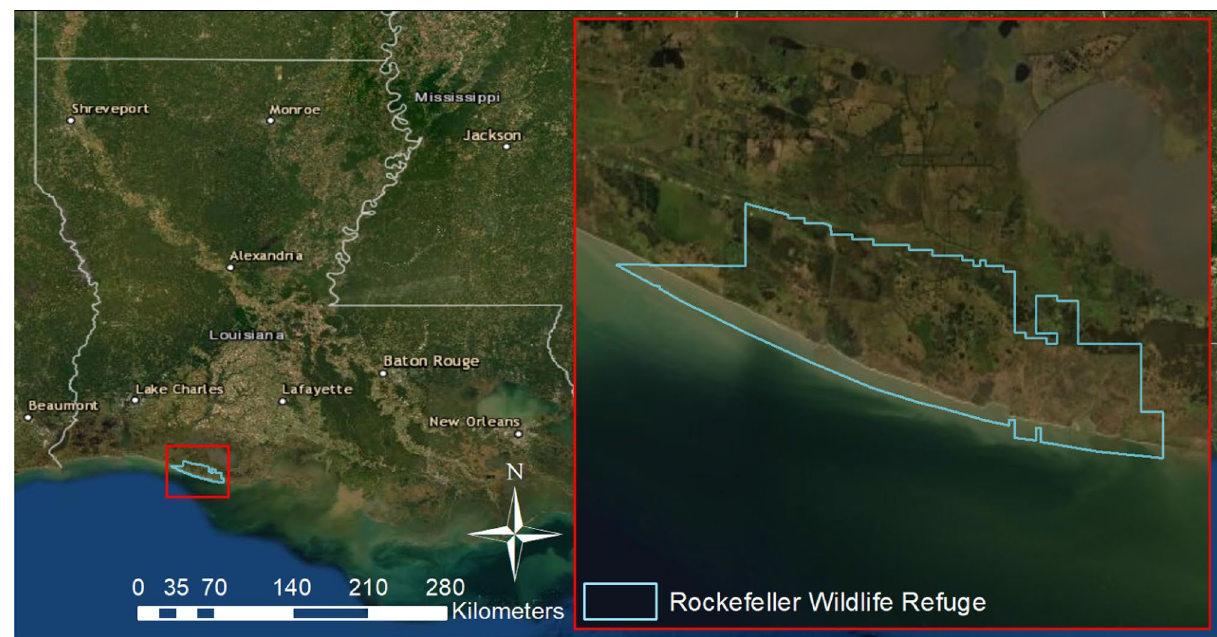
Figure 1. Rockefeller Wildlife Refuge in Grand Chenier, Louisiana (U.S.A.) where wild American alligators ( Alligator mississippiensis ) were sampled from various locations. Map generated using ArcMap version